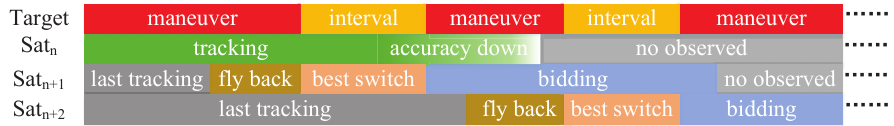
Figure 5. Sensor switching decision